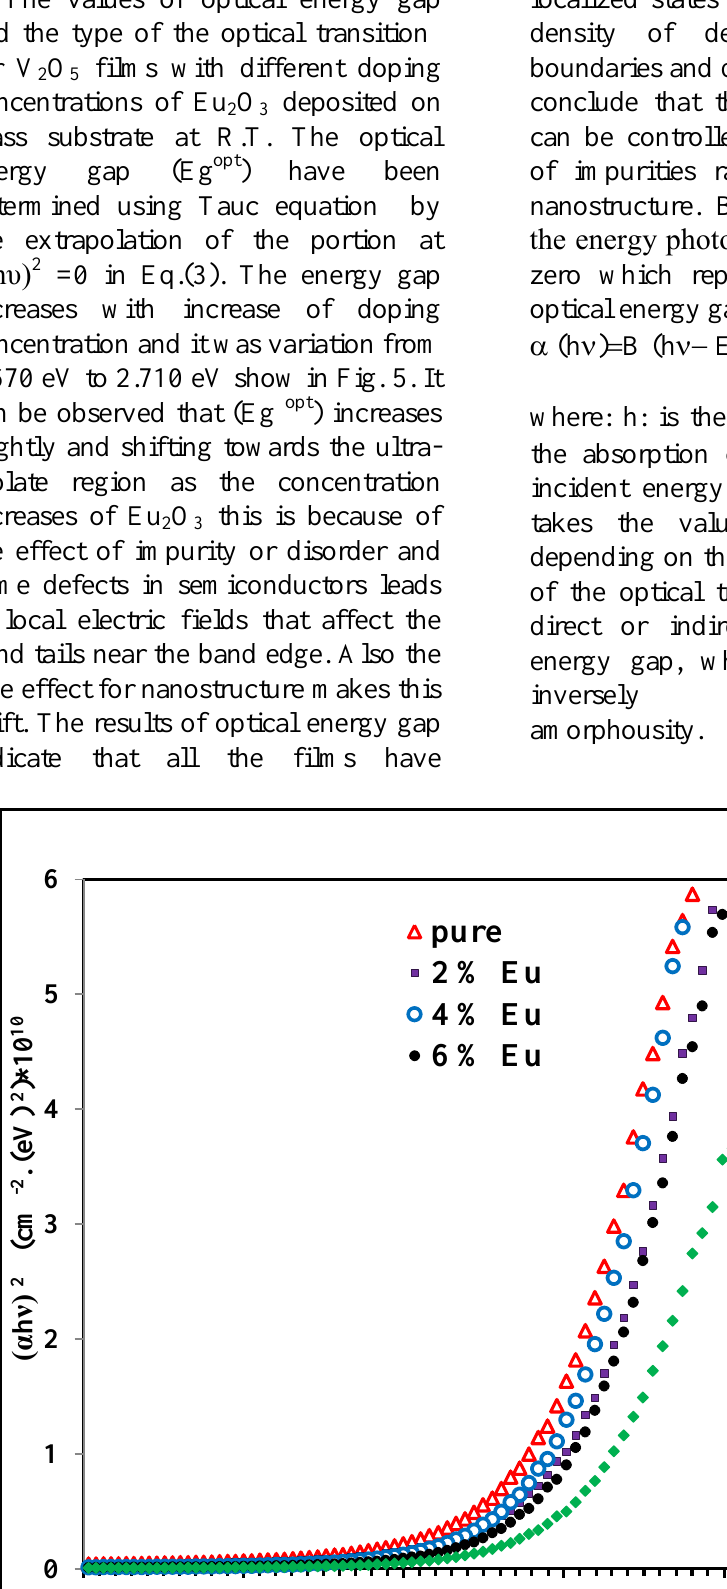
O films doped with (2, 4, 6, 2 5